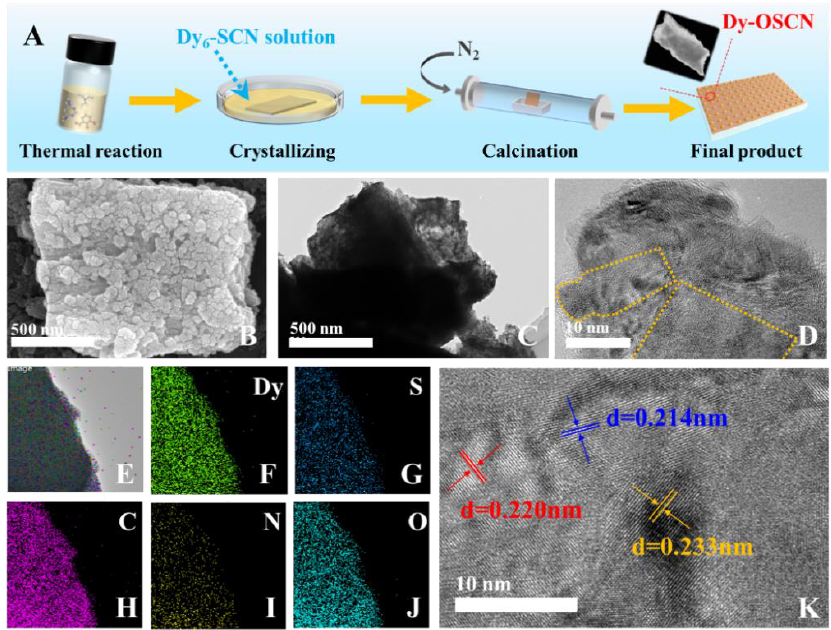
Figure 1. ( A ) Synthesis process of the Dy-OSCN monocrystal photocatalysts; ( B ) SEM image, ( C ) TEM image and ( D – K ) HR-TEM image of Dy-OSCN; ( E – J ) EDS images of Dy-OSCN.